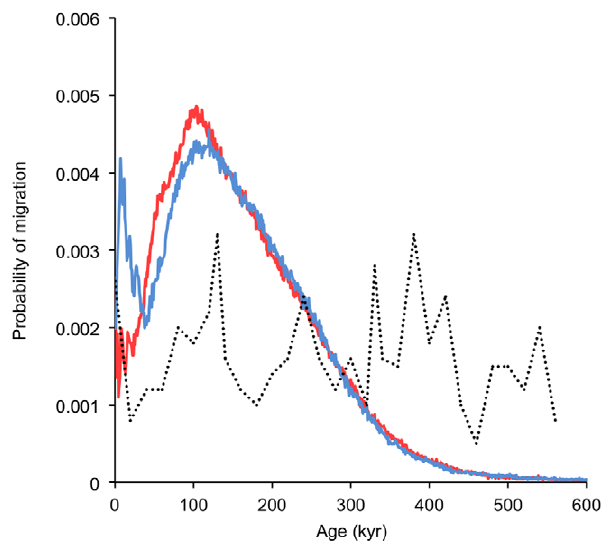
Figure 3. Probability distributions for migration events through time into the Atlantic (blue line) and Pacific (red line). The black broken line indicates the relative abundance of Agulhas leakage fauna based on data presented in ref. [59].